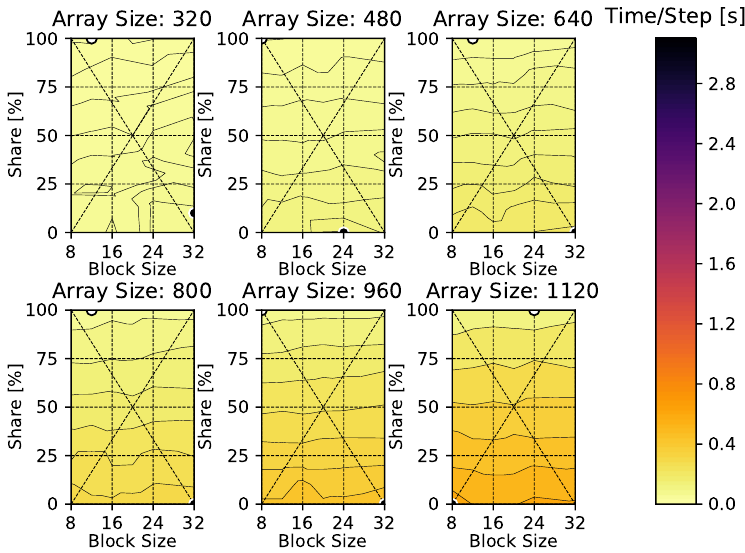
Figure A3. Heat equation time per timestep performance using Swept solver with Intel Skylake Silver 4114 CPUs and Tesla V100-DGXS-32GB GPUs.